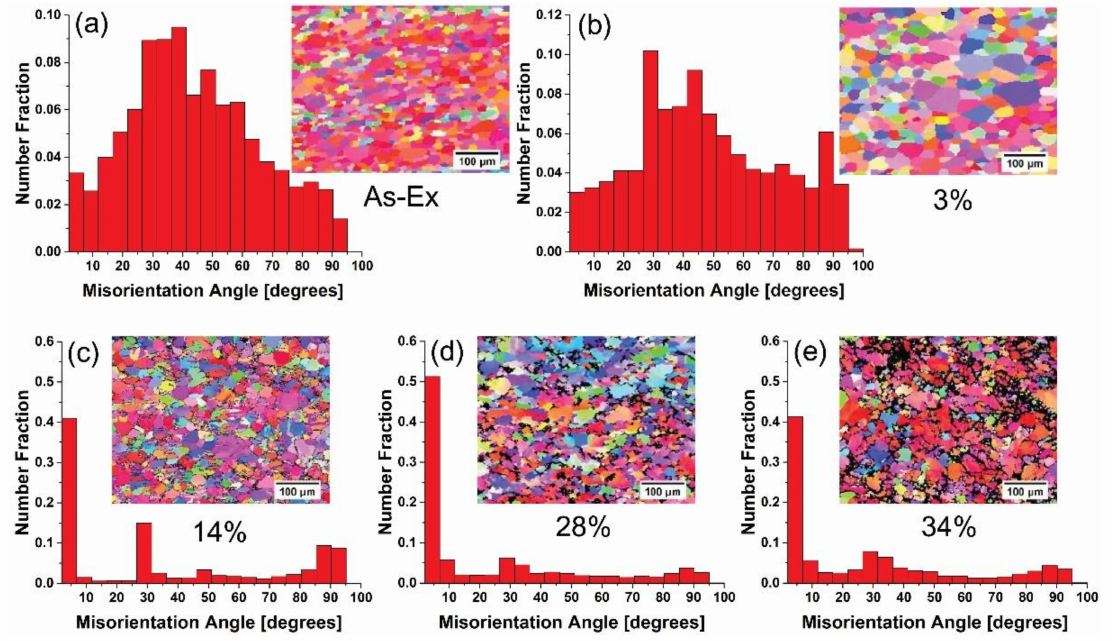
Figure 5. Misorientation angle distributions for pure Mg wire with different ATS: ( a ) as-extruded, ( b ) 3%, ( c ) 14%, ( d ) 28% and ( e )